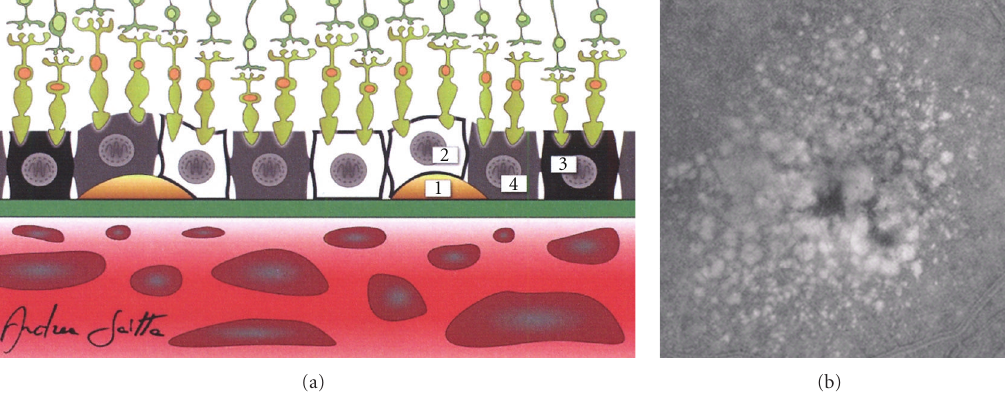
Figure 3: Intermediate age-related macular degeneration. (a) Schematic cross-sectional illustration of the macula with an intermediate stage of the disease ((1) drusen; (2) atrophy of a cell of the retinal pigment epithelium; (3) hypertrophy or hyperplasia of a cell of the retinal pigment epithelium; (4) a normal cell of the retinal pigment epithelium). (b) Fluorescein angiography of the macula a ff ected by an intermediate form of the disease (confluent soft drusen and pigmentary irregularities); in this eye, the best best-correct visual acuity was 20/50 (Snellen equivalent) (extracted and modified from